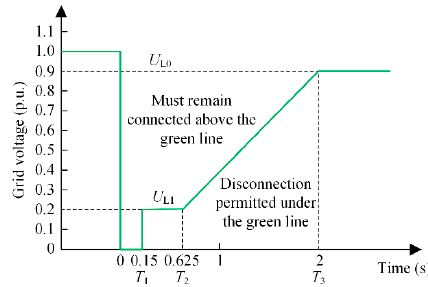
Figure 9. LVRT standard used for the PV inverter testing.